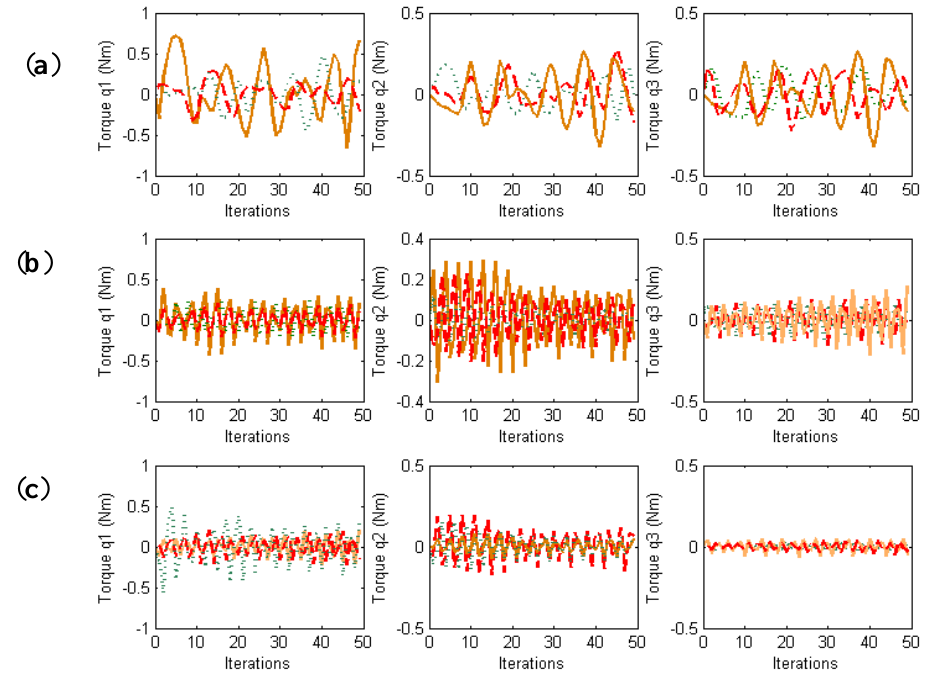
Figure 4. Torques obtained during the first set of experiments. ( a ) First finger. ( b ) Second finger. ( c ) Third finger. For each figure the torques obtained by the controllers indicated in the legend of Figure 3 are